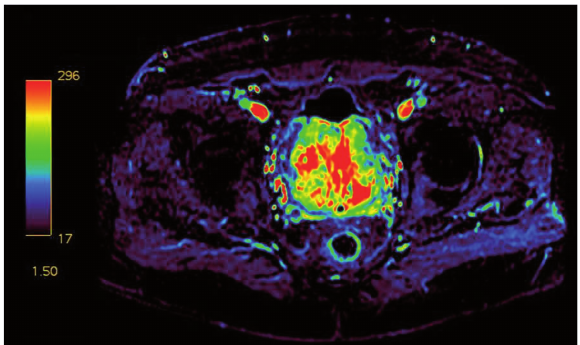
Figure 2 - Prostate MRI contrast-enhanced perfusion map showing a markedly increased perfusion.